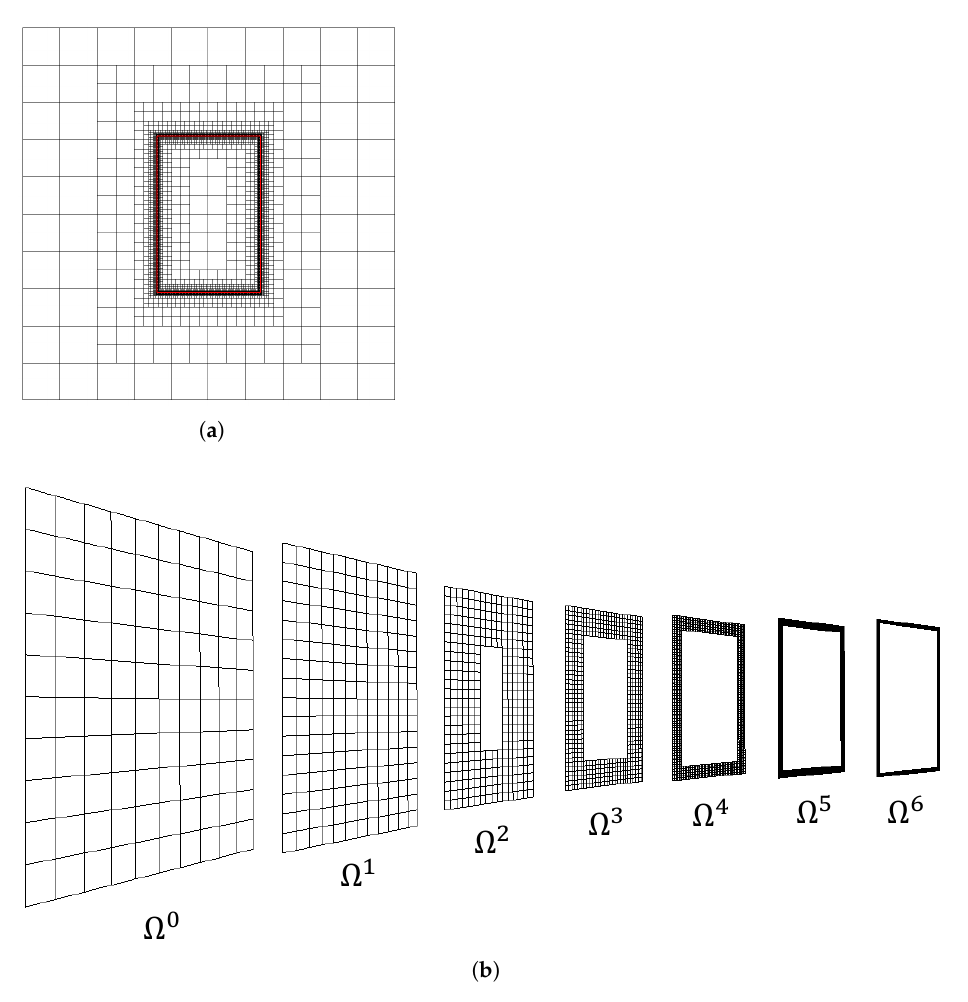
Figure 16. A two-dimensional seven-level hierarchical refinement of a square domain with respect to a rectangular immersed boundary: ( a ) hierarchical mesh and ( b ) sub-meshes in each level. Table 5. Computer time on a personal computer required for hierarchical refinement of the geometry shown in Figure